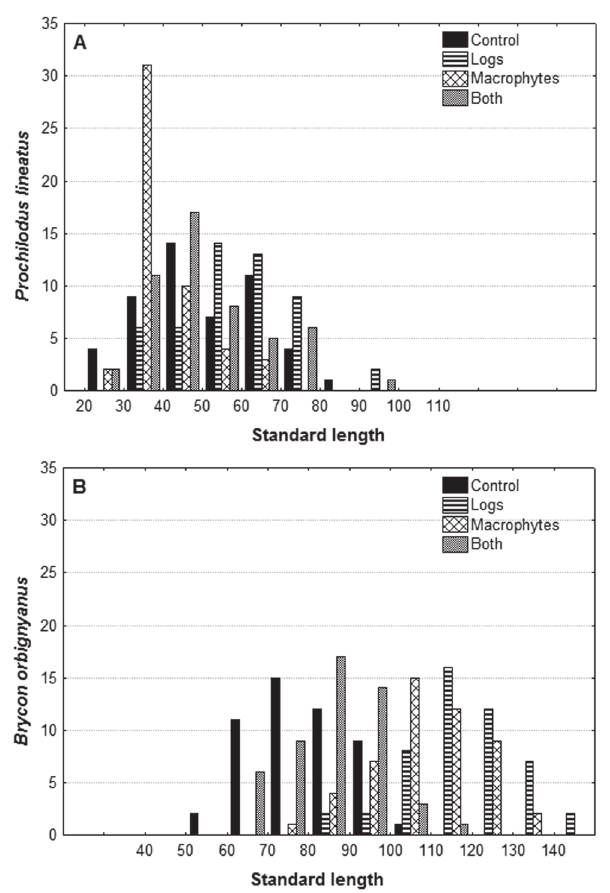
Fig. 2. The number of individuals for each species per class of standard length for each treatment.